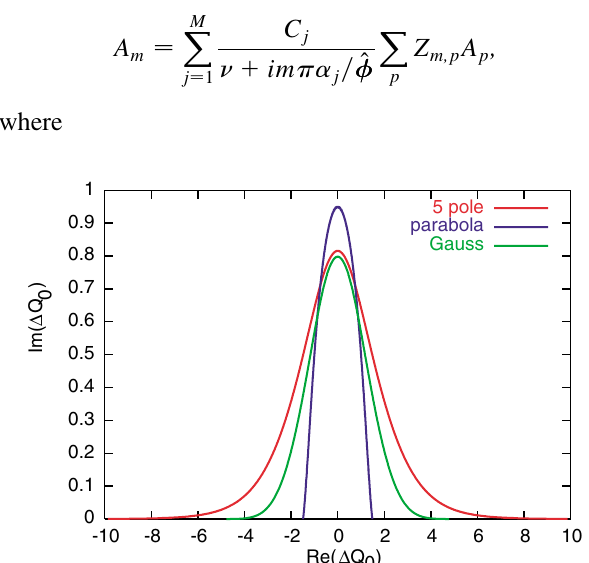
FIG. 11. (Color) Coasting beam thresholds for an M (cid:5) 5 dis- tribution, a Gaussian distribution, and a parabolic distribution all with (cid:26) (cid:3) v (cid:4) (cid:5) 1 .